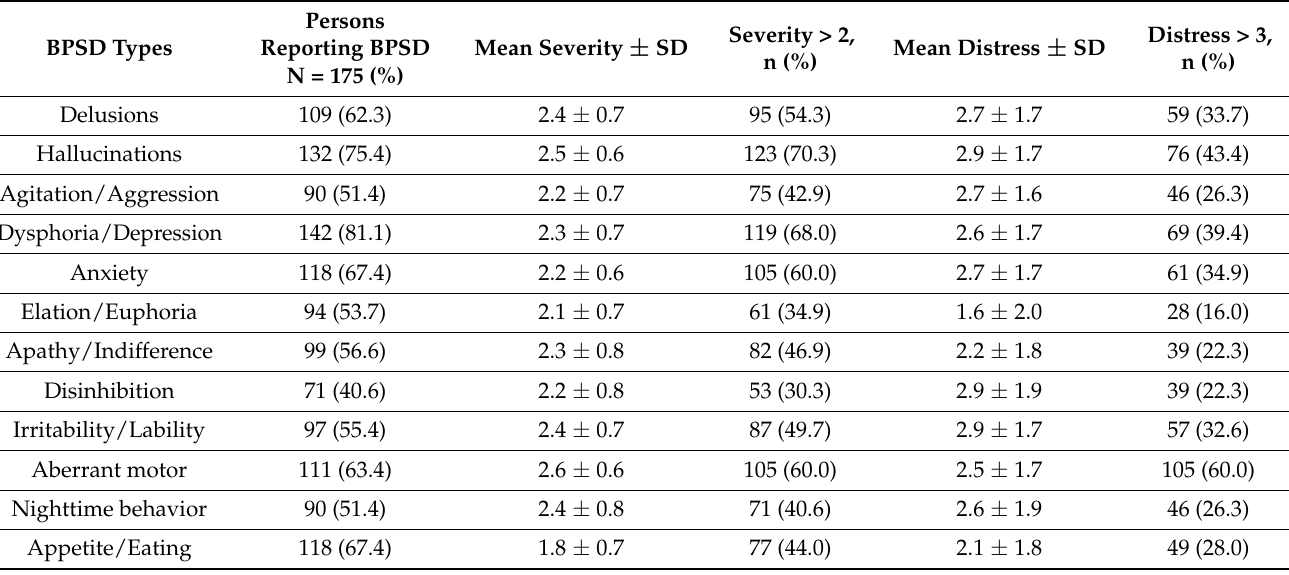
Table 2. Prevalence of each type of BPSD, mean severity and distress, and frequency of significant severity and distress per symptom as reported by a caregiver.